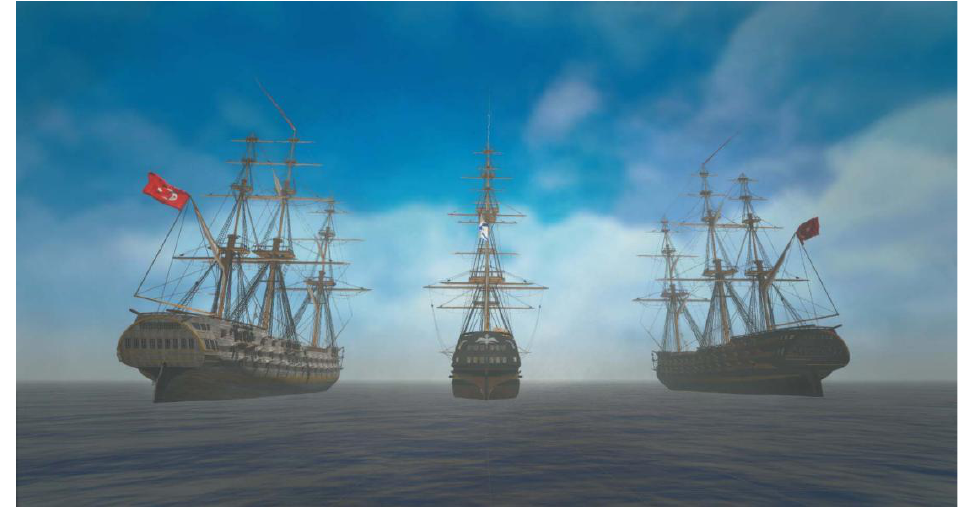
Figure 13 . Ships from the VR application “Ships of Navarino”. Screenshot from Unity3d . Figure 13. Ships from the VR application “Ships of Navarino”. Screenshot from